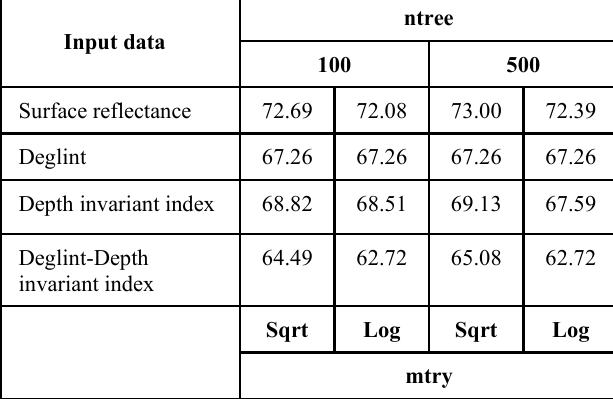
Table 2. Summary of RF classification scenario overall accuracy. The values are in %.